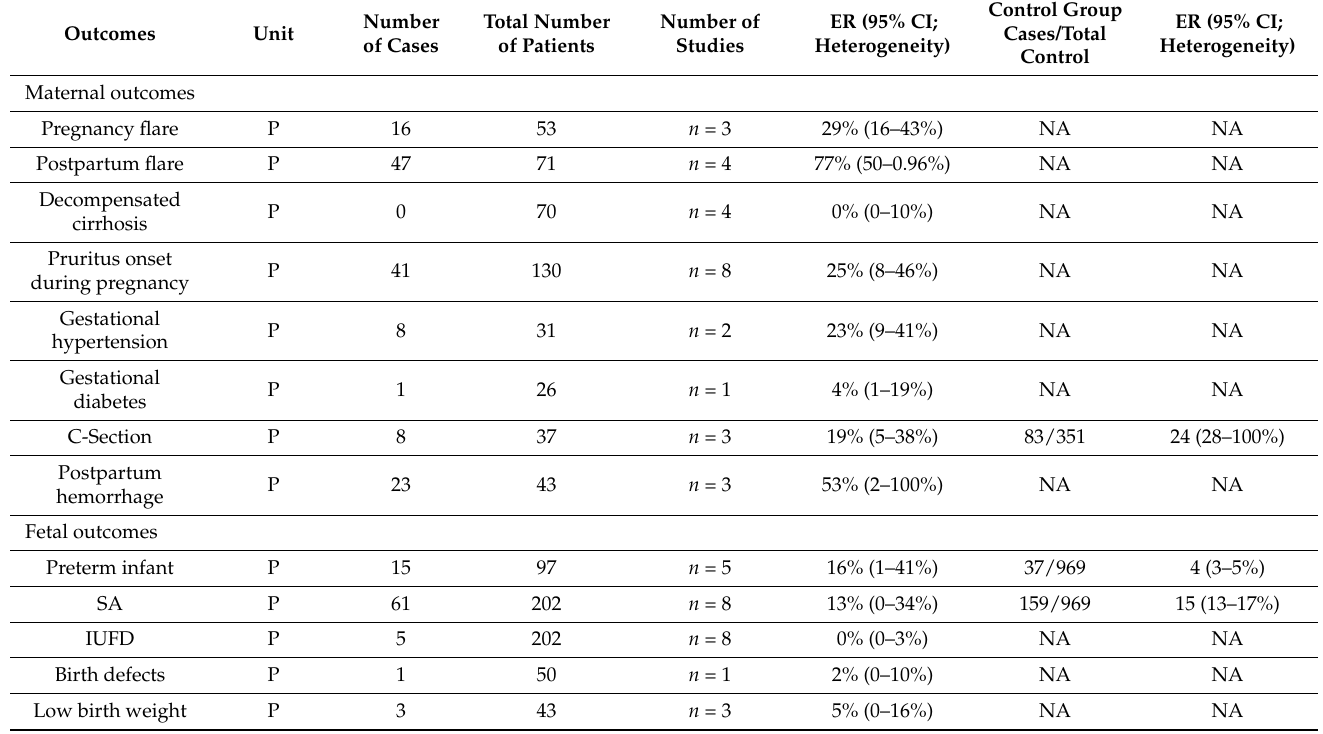
Figure 3. Birth defects (the event) in patients with PSC. PSC—Primary sclerosing cholangitis; OR— Odds ratio; CI—Confidence interval. Table 3. Prevalence data of maternal and fetal outcomes in patients with primary biliary